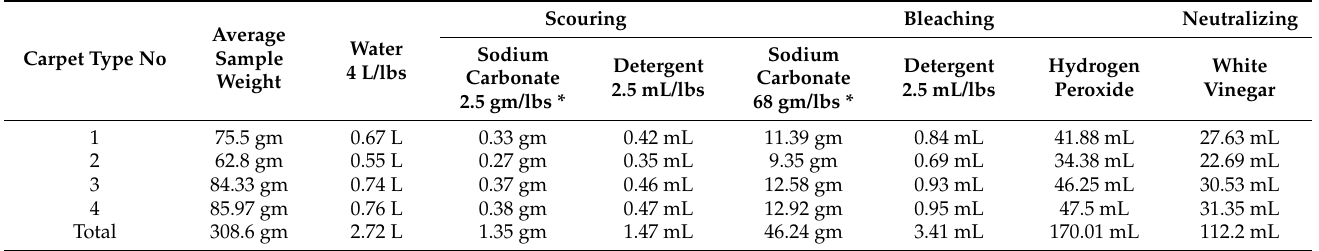
Table 2. Amount of Chemicals required for the scouring and bleaching process for a single batch.